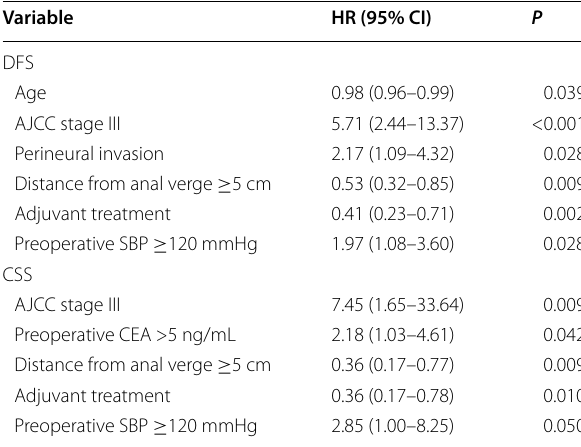
Table 4 Multivariate analysis of prognostic factors for DFS and